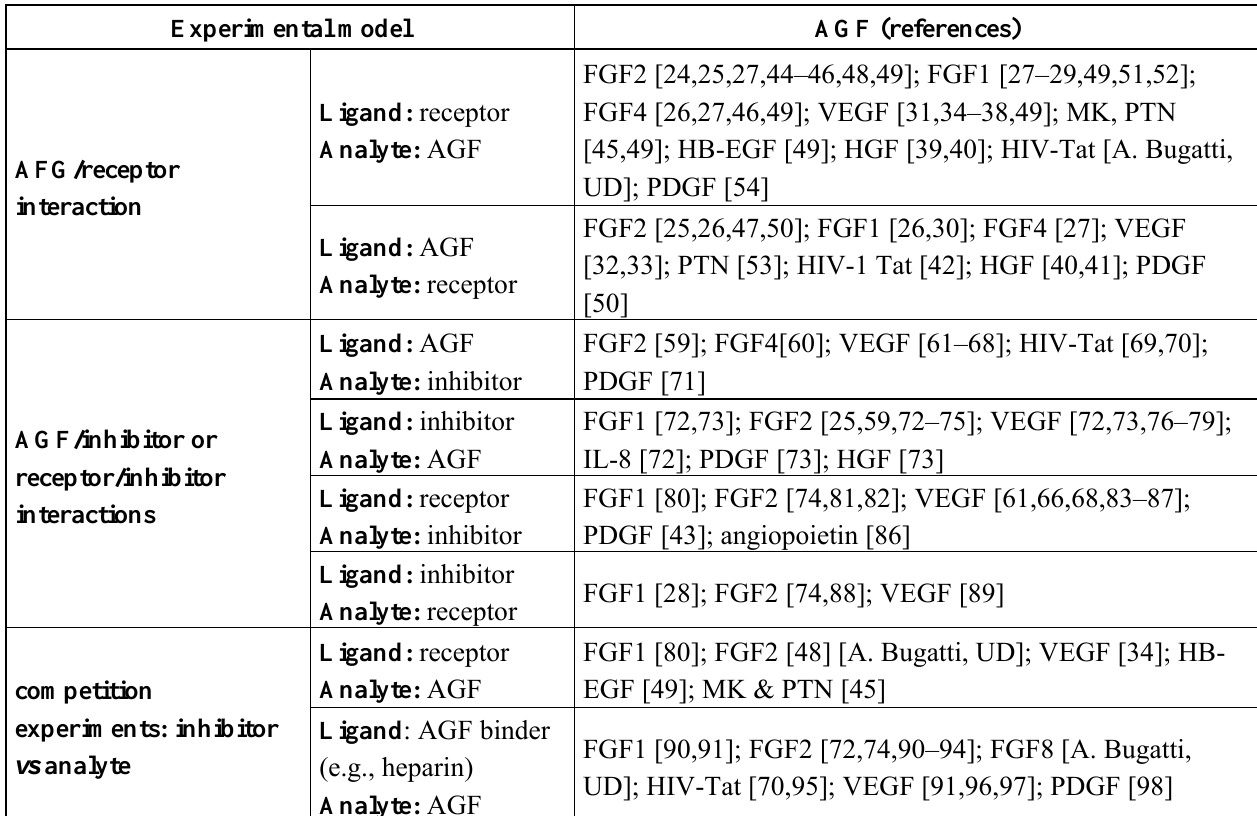
Table 3. SPR-based experimental models utilized to study AGF/receptor interactions and to identify AGF/receptor